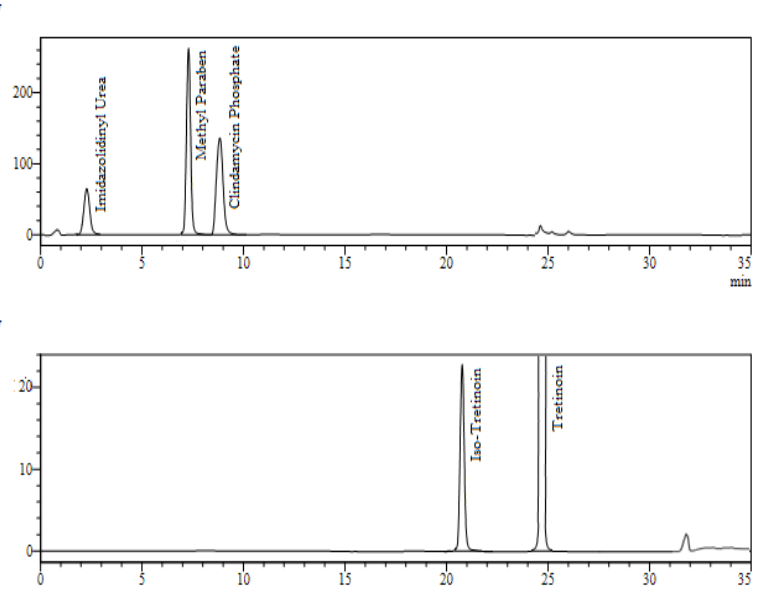
Figure 5. HPLC chromatogram of experimental gel preparation after 10 h stress testing in sunlight (25 – 30 °C). Peaks: imidazolidinyl urea, t R ∼ 2.2 min; methyl paraben, t R ∼ 7.3 min; clindamycin phosphate, t R ∼ 8.9 min; iso-tretinoin, t R ∼ 20.8 min; tretinoin, t R ∼ 24.8 min.